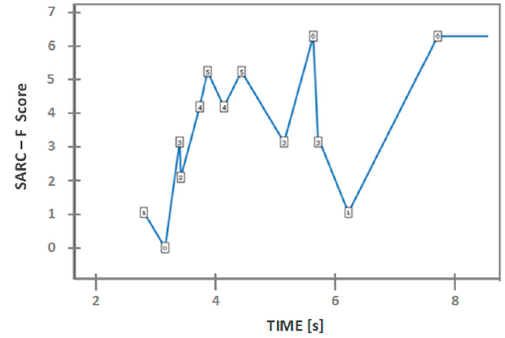
Figure 6. Visualization of graph SARC-F–time.